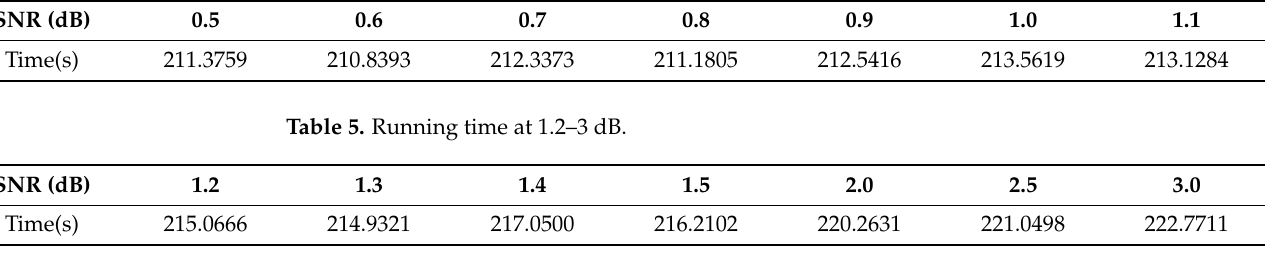
Table 4. Running time at 0.5–1.1 dB.